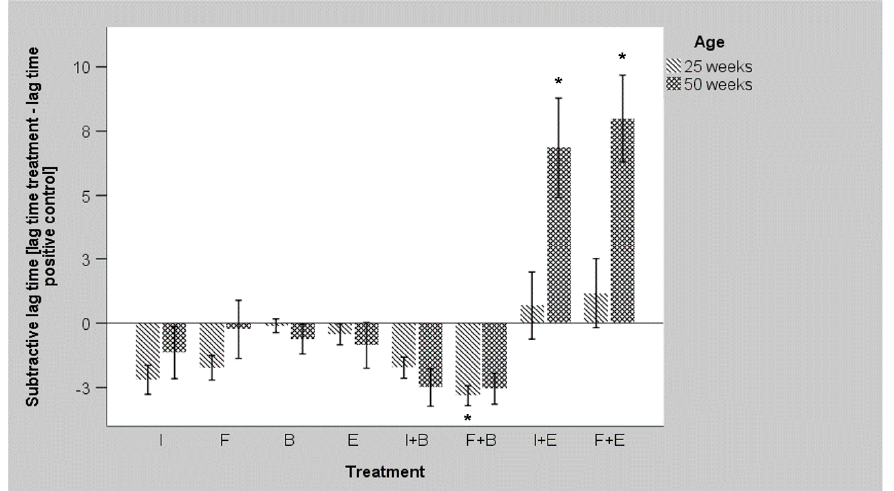
Figure 4. Comparison of different treatments and ages regarding the lag time [h] of S. Enteritidis (I = Inulin, F = FOS, E = Enterococcus faecium , B = Bacillus coagulans , + = combination; mean values, n = 15 for each age, all farms included, error bars indicate the SEM, significant differences compared to positive control are indicated by asterisks).